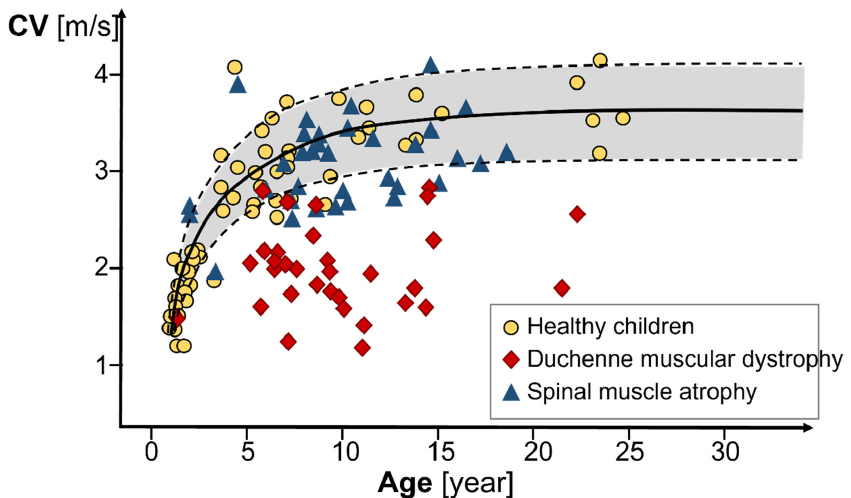
Figure 24. Change in the mean conduction velocities of motor unit action potentials (MUAP CVs) with age in healthy subjects and in patients suffering from Duchenne muscular dystrophy or spinal muscle atrophy. The solid black line is the regression curve for the healthy subjects. The gray area contains 95% of all healthy subjects. Adapted with permission from Ref. [55]. Copyright Muscle and Nerve, 1997.